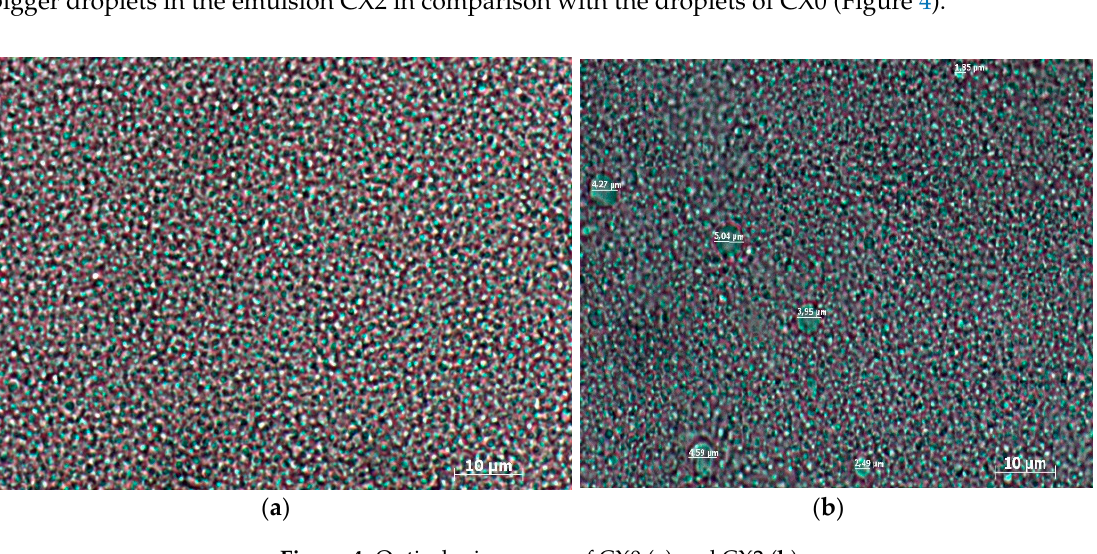
Figure 3. Trends of G ′ and G ″ as a function of temperature of samples prepared with the different concentrations of Bosexil ® (0%, 0.5%, 1%, 2%).